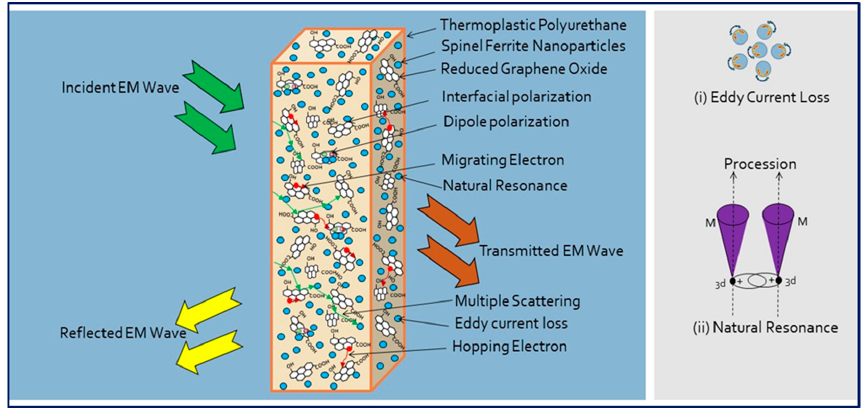
Figure 11. Schematic illustration of EMI shielding mechanism based on developed Cu x Co 1 ‐ x Fe 2 O 4 (x = 0.33, 0.67, and 1.00) ‐ rGO ‐ TPU nanocomposites.